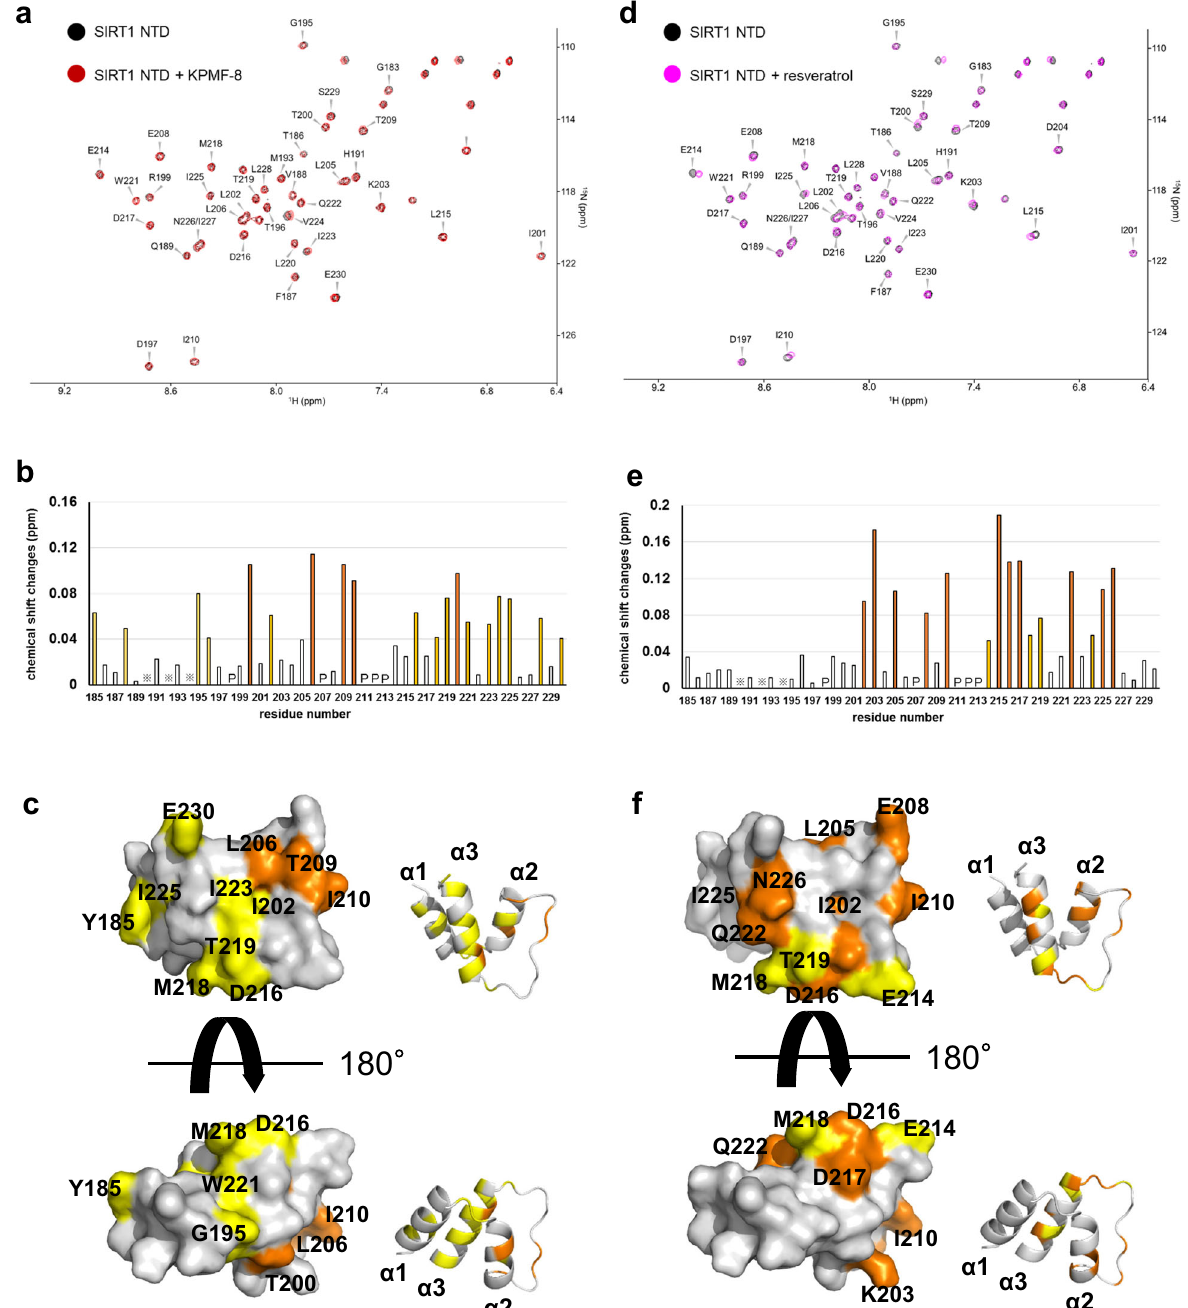
Fig. 5 Binding of KPMF-8 or resveratrol to the 15N-labeled SIRT1 NTD analyzed by NMR. Superposition of 1 H- 15 N HSQC spectra of 40 µ M 15 N-labeled SIRT1 NTD alone (black) and in the presence of a 400 µ M KPMF-8 or d 400 µ M resveratrol. The chemical shift changes of 15 N-labeled SIRT1 NTD between the free state and the bound state to b KPMF-8 or e resveratrol. Asterisks and P ’ s represent unassigned and unobservable proline residues, respectively. Mapping of the chemical shift-perturbed residues on the SIRT1 NTD by binding to c KPMF-8 or f resveratrol. The residues in c and f are colored according to the extent of chemical shift change de fi ned by the formula δ Δ = ( δ Δ HN 2 + 0.25 × δ Δ 15N 2 ) 1/2 : white, 0.00 – 0.04 p.p.m.; yellow, 0.04 – 0.08 p.p.m.; orange, >0.08